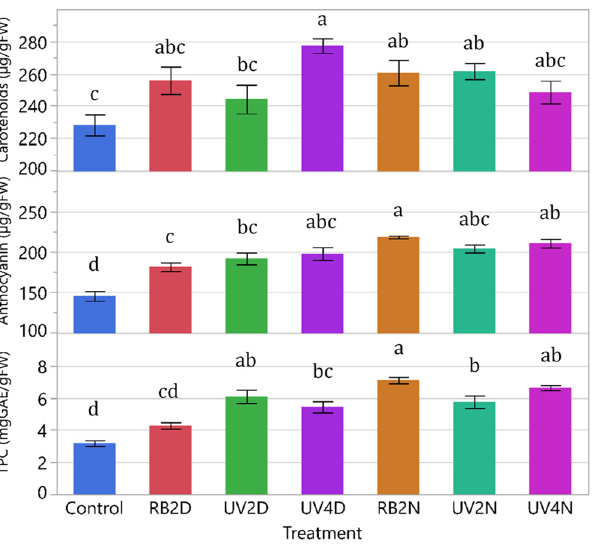
Figure 4. Carotenoids, anthocyanin, and total phenolic content (TPC) of leaf tissue samples from the lettuce variety ‘Red Mist’ treated with pre-harvest supplemental UV-A/Blue (UV) or Red and Blue (RB) LED light for a duration of either two or four days (D) or nights (N), in a greenhouse hydroponic system (Experiment 1). The control plants did not receive any supplemental LED light. See Table 2 for treatment details. Means separated by different letters indicate significant differences according to Tukey’s HSD (honestly significant difference) test ( p < 0.05). Bars represent standard error.